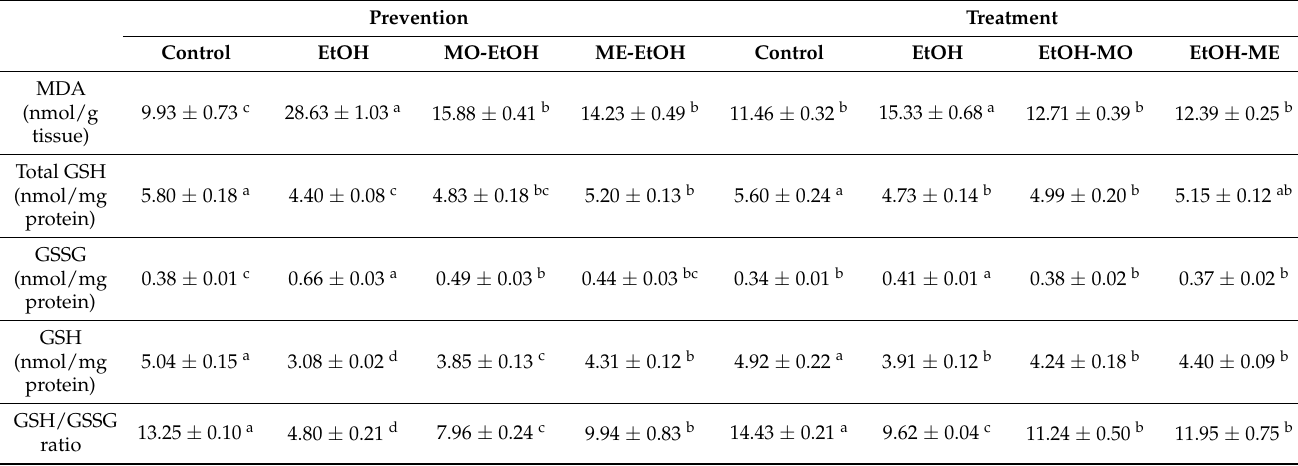
Table 6. Effect of myrrh oil and myrrh extract on malondialdehyde (MDA), total glutathione (total GSH), oxidized glutathione (GSSG), reduced GSH, and GSH/GSSG ratio.